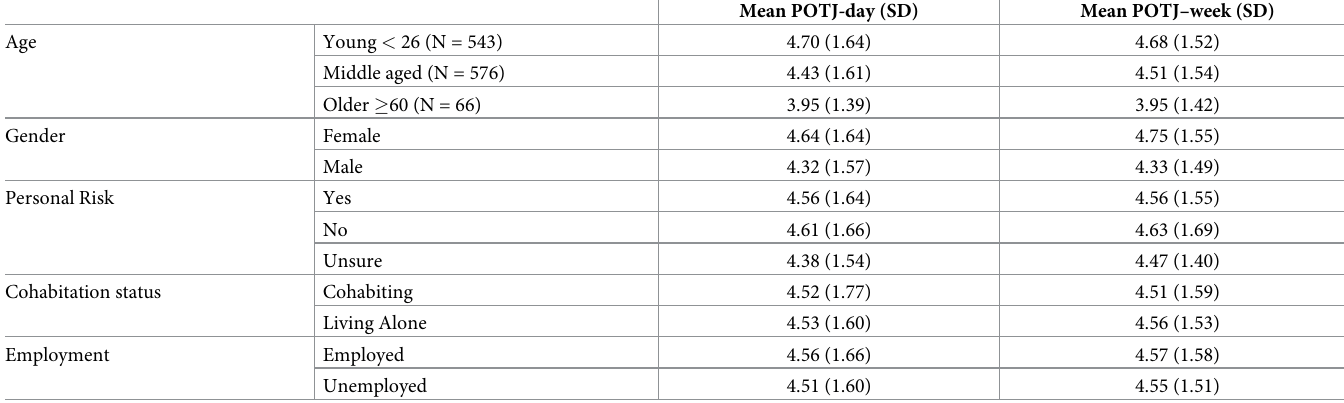
Table 3. The mean POTJ for each displayed as a function of age, gender, employment, personal risk and cohabitation status.